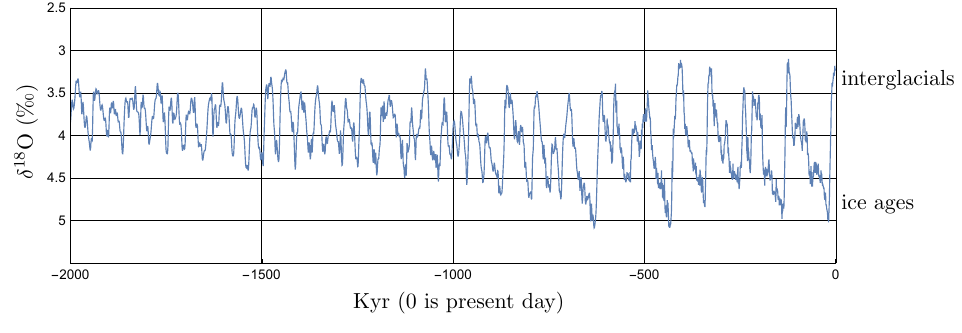
Figure 1. δ 18 O is a proxy for global ice volume, with larger values corresponding to more ice and colder periods. Data from